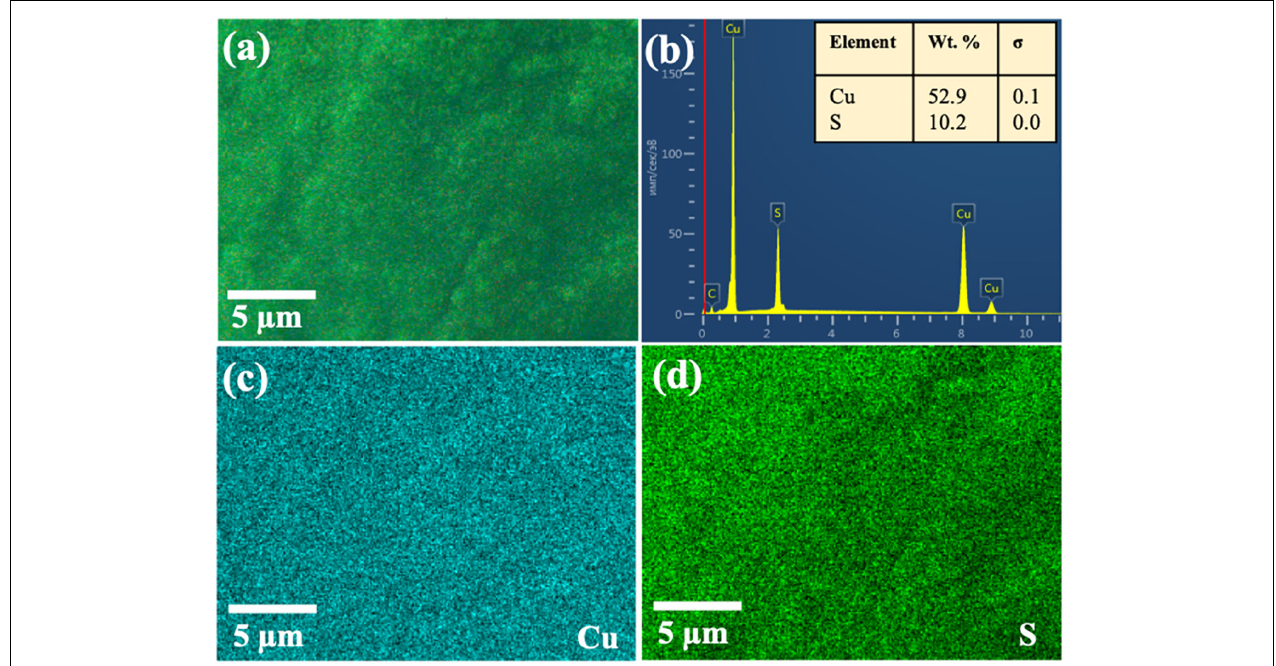
FIGURE 5 | Scanning electron microscope–EDS mappings of obtained Cu 1 . 8 S on Cu foam: (a) pristine sample, (b) EDS spectra, (c) Cu and (d) S element mapping